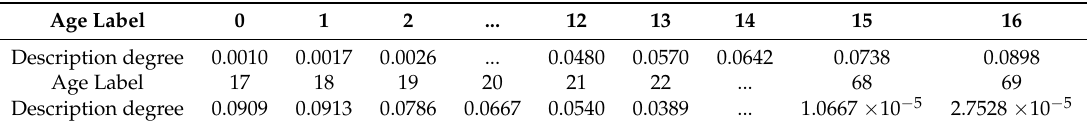
Table 1. An example of the obtained age label distribution for a new facial image x (cid:48) (with the authentic age of 16).